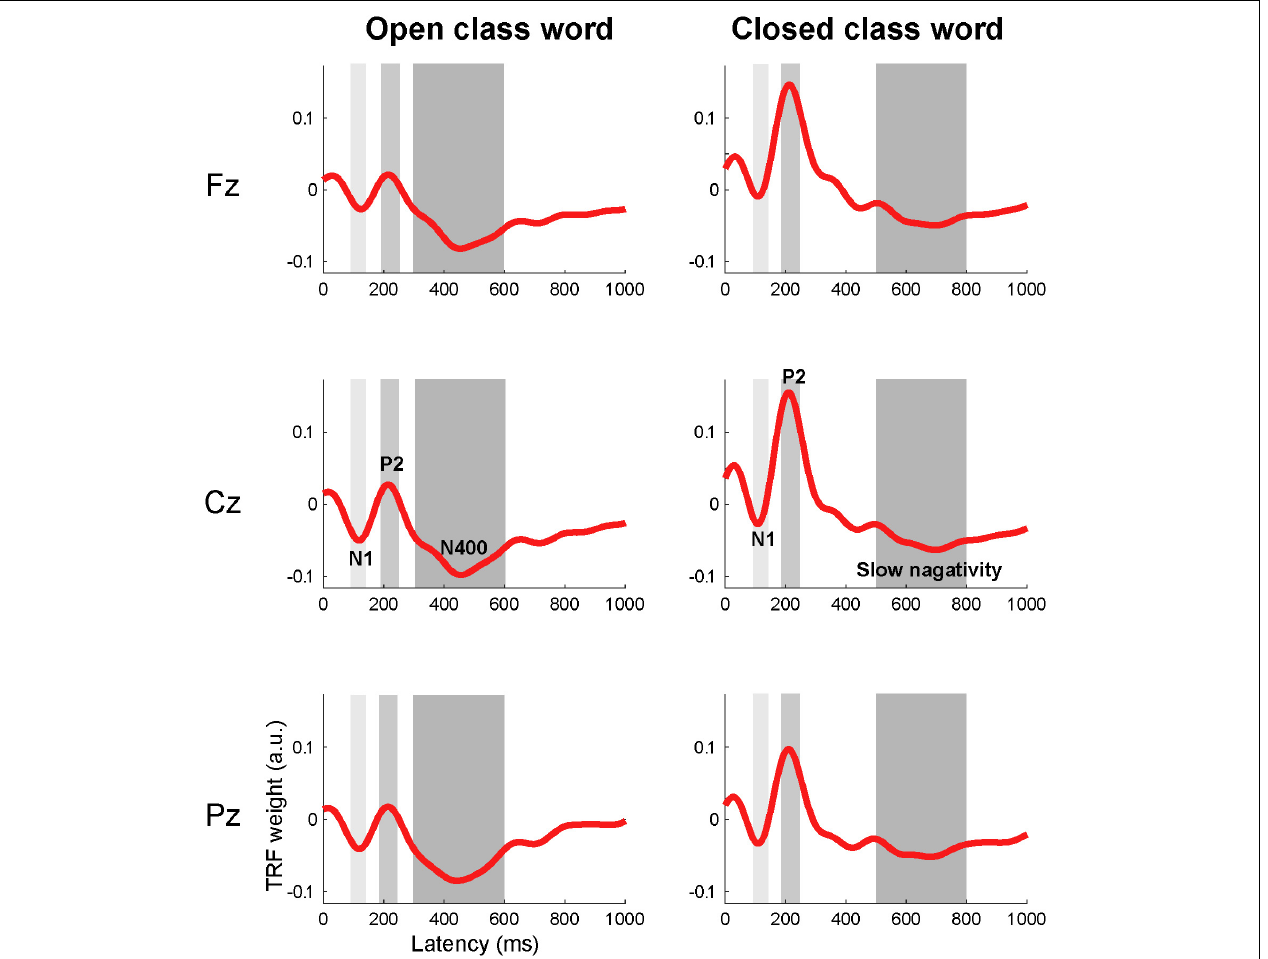
FIGURE 2 | Grand-averaged TRFs across all 199 participants for open and closed class words. Two early components, corresponding to N1 and P2, are shown in the TRFs for both open and closed words at all three channels. The peak latencies were slightly shorter in the TRFs for the closed class words (N1: 110 ms; P2: 210 ms at Cz) than those for the open class words (N1: 120 ms; P2: 215 ms at Cz). The TRFs for the open class words showed a late component, corresponding to the N400, and the TRFs for the closed class words showed a later and slower negativity. The peak latencies for the open class words and the closed class words at Cz were 455 and 700 ms, respectively. Gray shades show the latency ranges used to estimate the mean amplitudes of each component: 90–140 ms for the N1 (light gray), 190–250 ms for the P2 (median gray), and 300–600 and 500–800 ms for the late component for the open and closed words (dark